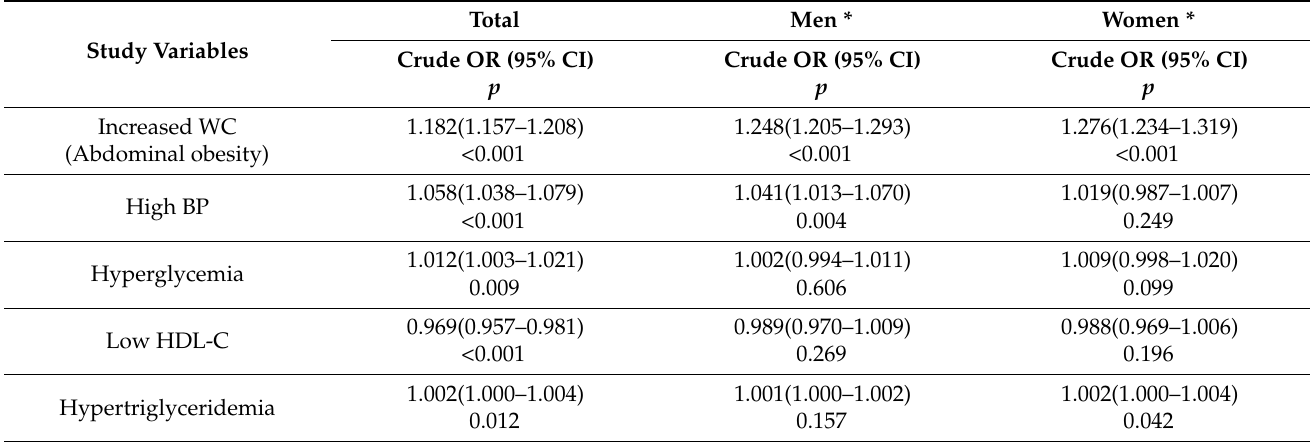
Table 4. Association between NC (categorical variable) and the risk of MetS components by sex.